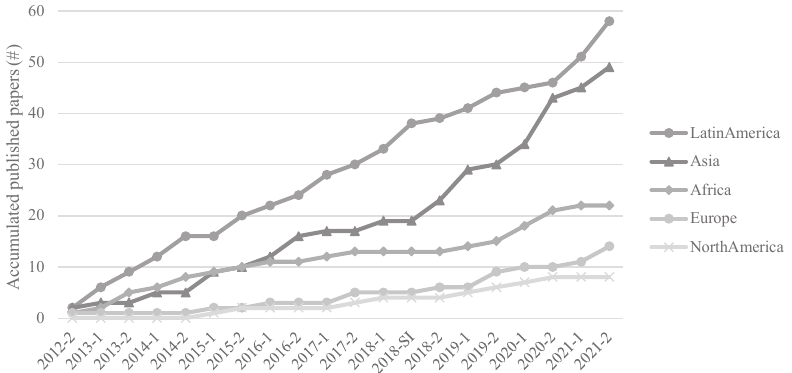
published papers by the regional origin of the corresponding